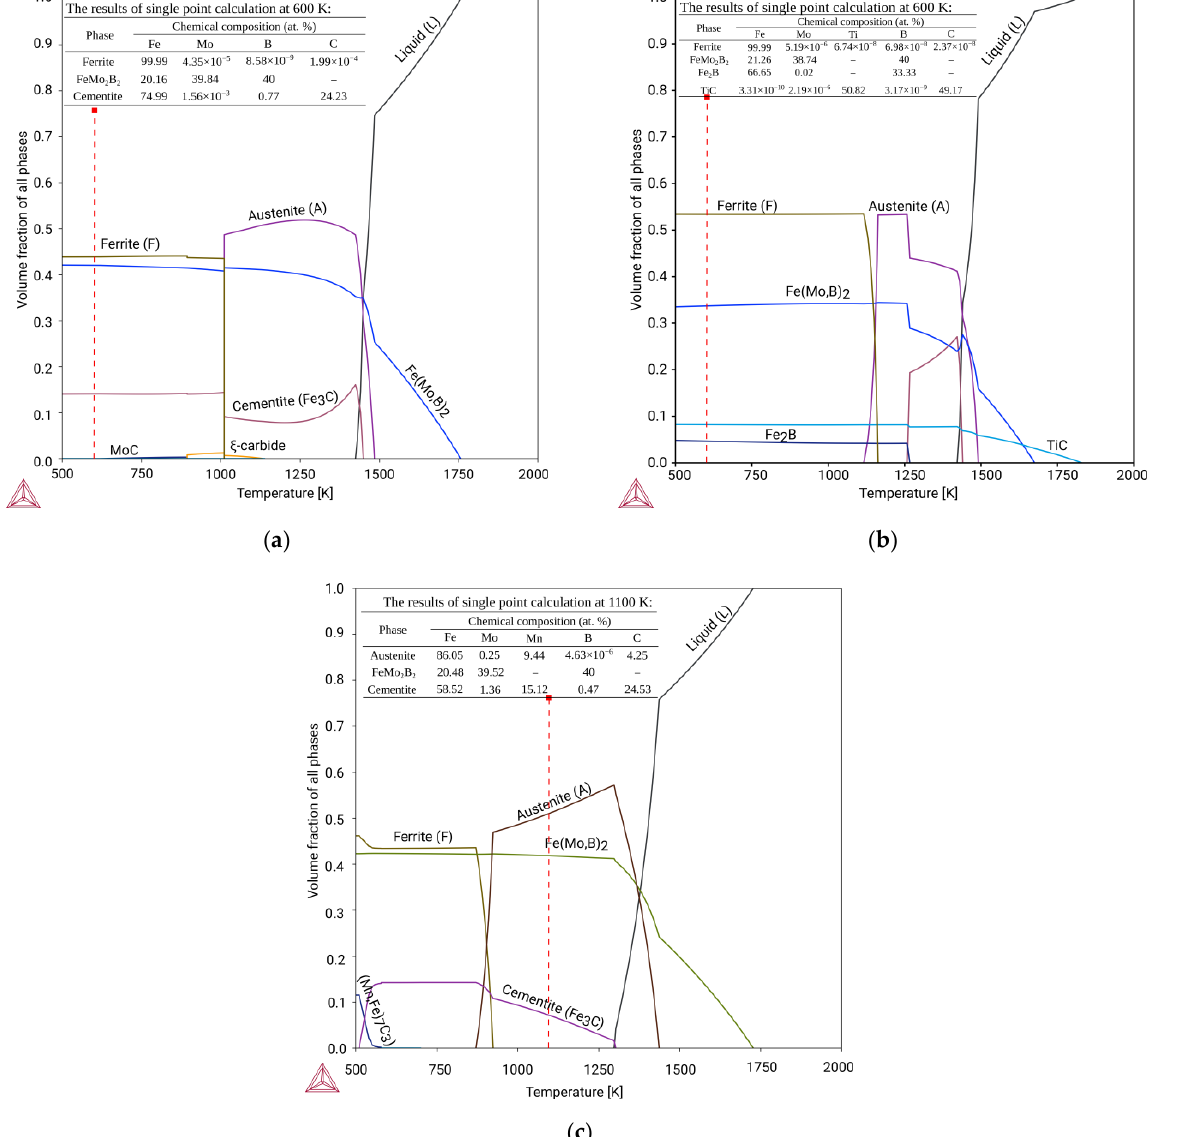
Figure 6. Calculated temperature step diagrams of experimental hardfacing alloys: ( a ) Sample 1; ( b ) Sample 2; ( c ) Sample 3.